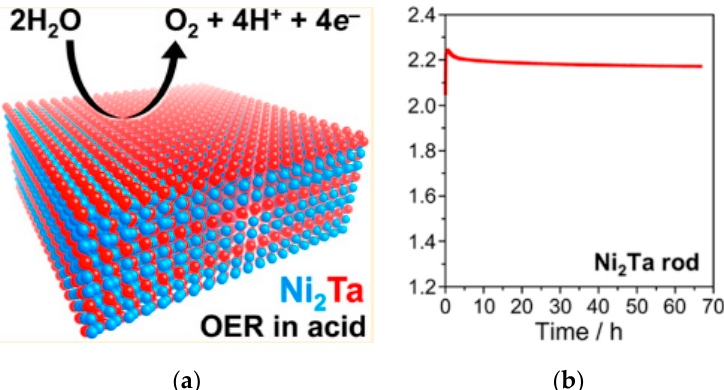
Figure 22. ( a ) Synthesis route of the N ‐ doped WC nanoarrays; ( b ) i ‐ V curves of water splitting with the N ‐ WC as anode and cathode electrodes compared with N ‐ WC as the cathode and Ir/C as the anode; ( c ) Video snapshot of the water electrolysis with a 1.5 V commercial battery. Reprinted with permission from [217]. Copyright 2018 Nature Publishing Group.